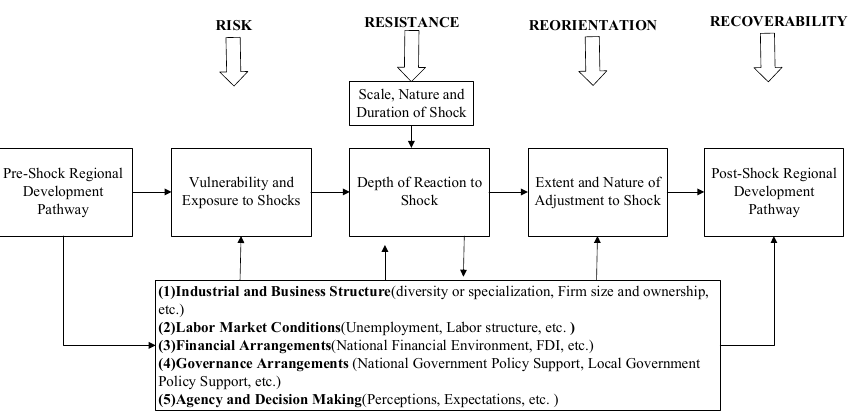
Figure 1. The conceptual framework of regional economic resilience. Source: Adapted from Martin et al. (2016) [2].